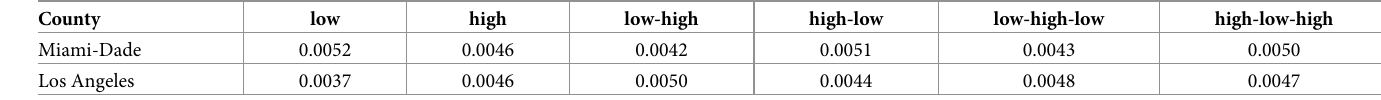
Table 1. MDAE using synthetic data from different counties and disease